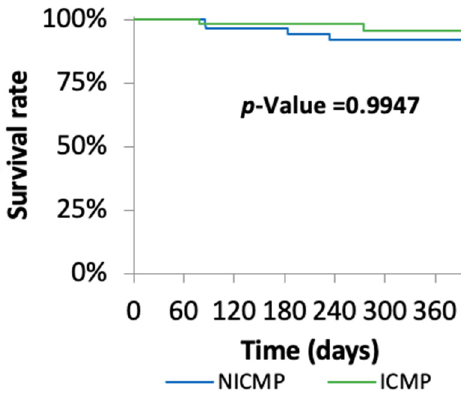
Figure 2. Kaplan–Meier survival analysis. Table 3. Device therapy and the impact on the outcome.